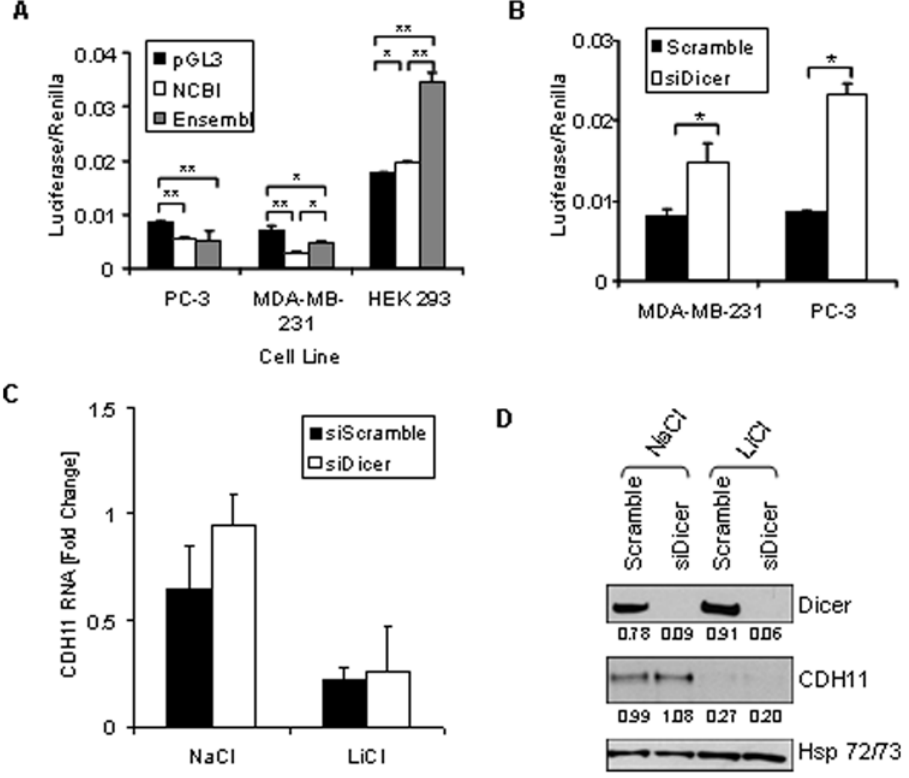
Figure 4. The stabilizing and destabilizing effects of the cadherin-11 3 9 UTR. A: PC-3, MDA-MB-231, and HEK 293 cells were transfected with pGL3-Promoter, pGL3-CDH11-3 9 UTR NCBI, or pGL3-CDH11-3 9 UTR Ensembl and pCMV-Renilla. 48 hours after transfection, cells were lysed using passive lysis buffer and luciferase activity was analyzed. (* indicates a p-value . 0.01; ** indicates a p-value . 0.001) B: MDA-MB-231 and PC-3 cells were transfected with pGL3-CDH11 3 9 -UTR and pCMV-Renilla along with either non-specfic siRNA (siScramble) or siRNA directed against Dicer (siDicer). 48 hours after transfection, cells were lysed using passive lysis buffer and luciferase activity was analyzed. (* indicates a p-value . 0.05) C and D: MDA-MB-231 cells were transfected with non-specific siRNA (siScramble), or siRNA directed against Dicer (si Dicer). Cells were collected for real-time PCR (C) and Western blot (D) analysis 72 hours after transfection.